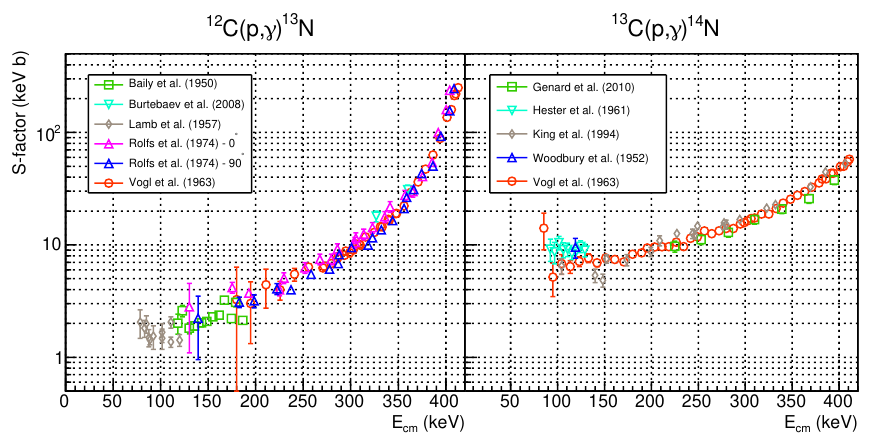
Figure 1: The state of the art for the 12 C( p , γ ) 13 N (on the left) and the 13 C( p , γ ) 14 N (on the right). For the latter, only the transition to the ground state is